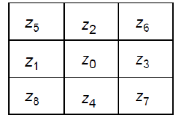
Figure 1: structural element with 3×3 kernel size (Li